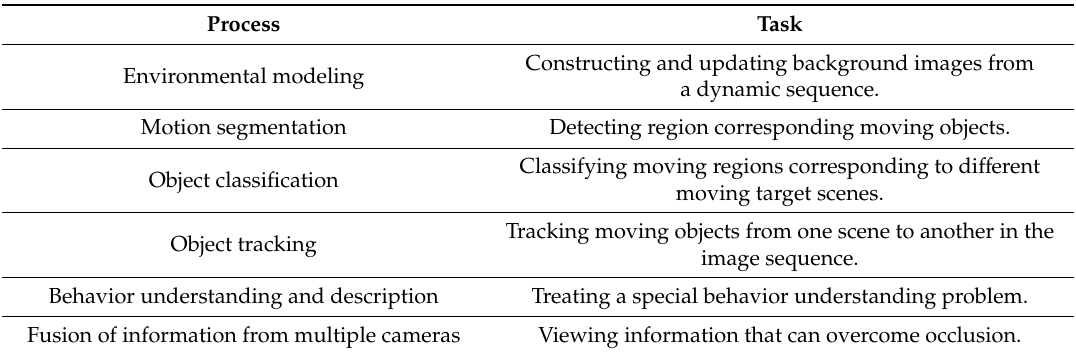
Table 1. Weiming’s proposed model, including processes and tasks